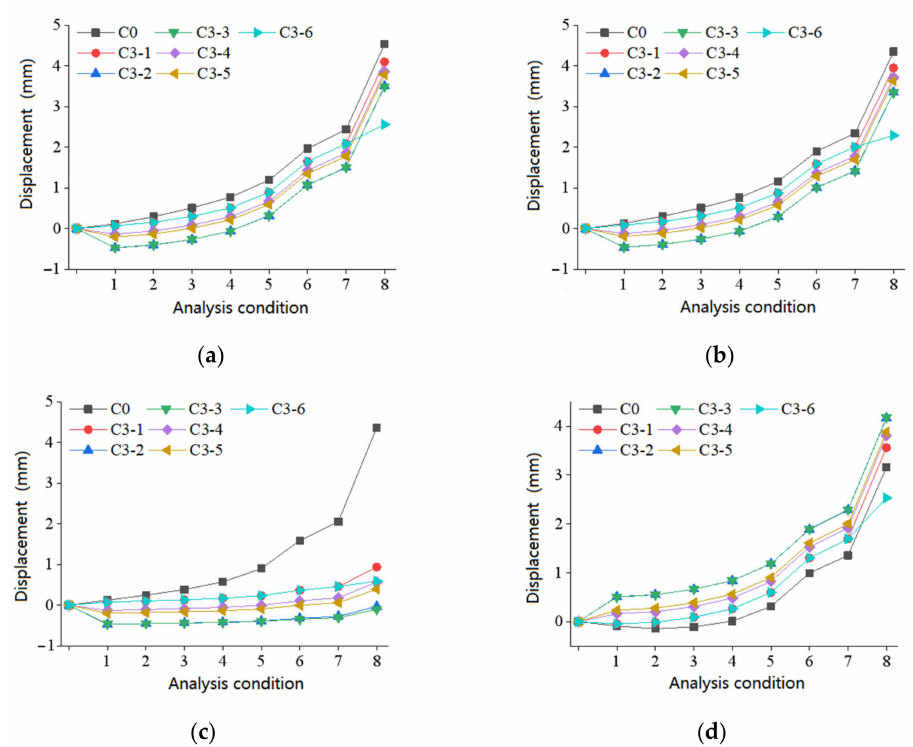
Figure 9. Model C3/C0 displacement analysis results (mm): ( a ) W2 displacement change; ( b ) W3 displacement change; ( c ) W4 displacement change; ( d ) W5 displacement